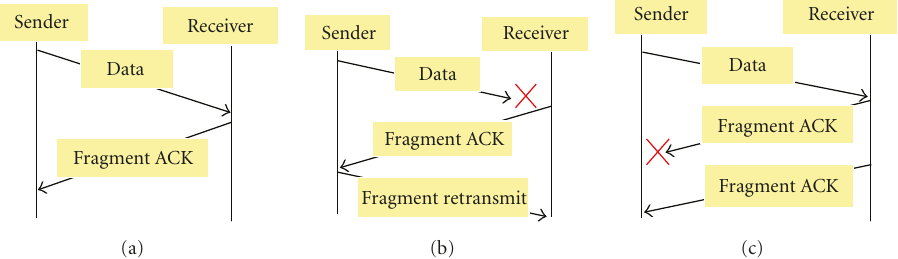
Figure 1: Typical protocol messaging for the SRVF protocol: (a) data and ACK Frames received correctly, (b) one or more fragments in error, and (c) ack in error.